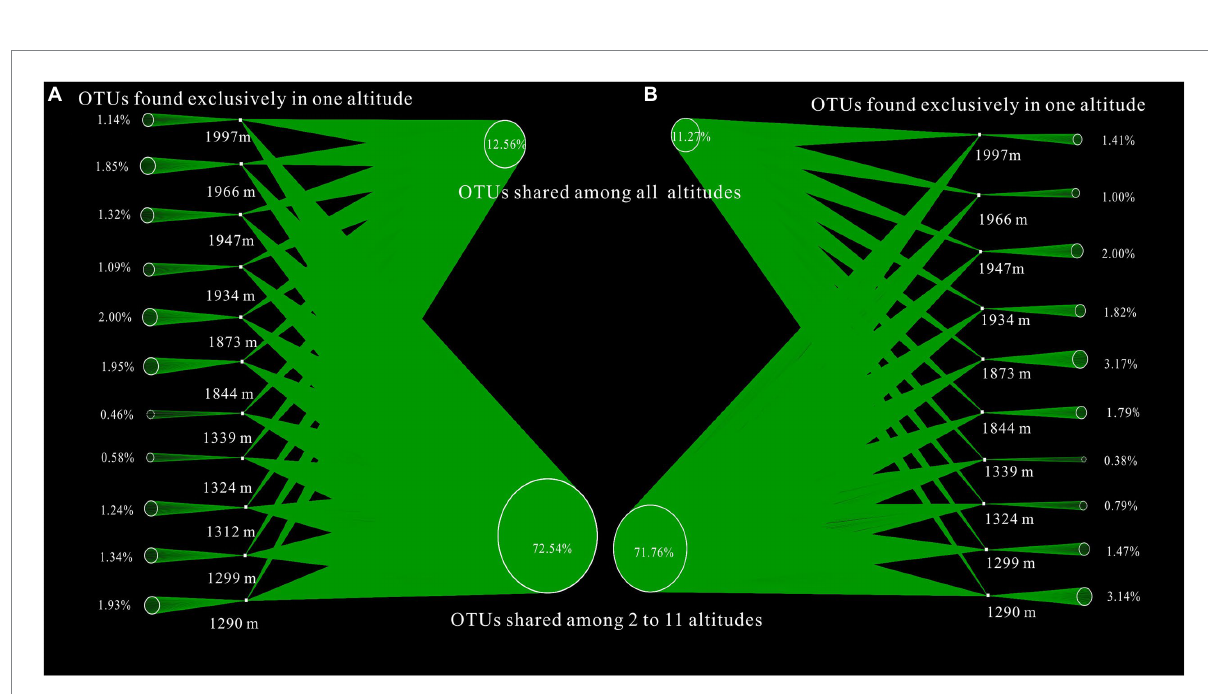
FIGURE 5 Influences of altitudinal gradients on the proportions of shared and unique OTUs based on network-based visualization (A) indicating A layer and (B) indicating B